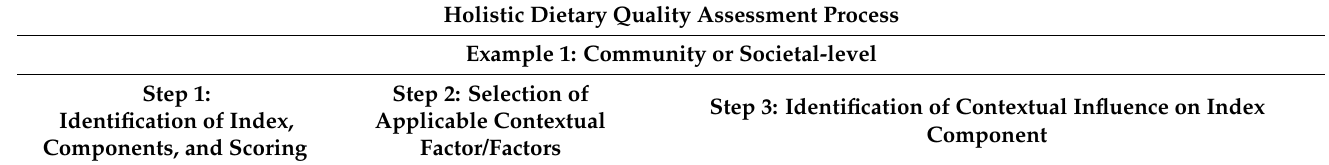
Table 3. Holistic Dietary Quality Assessment Process, Example 1: Community or Societal level. Holistic Dietary Quality Assessment